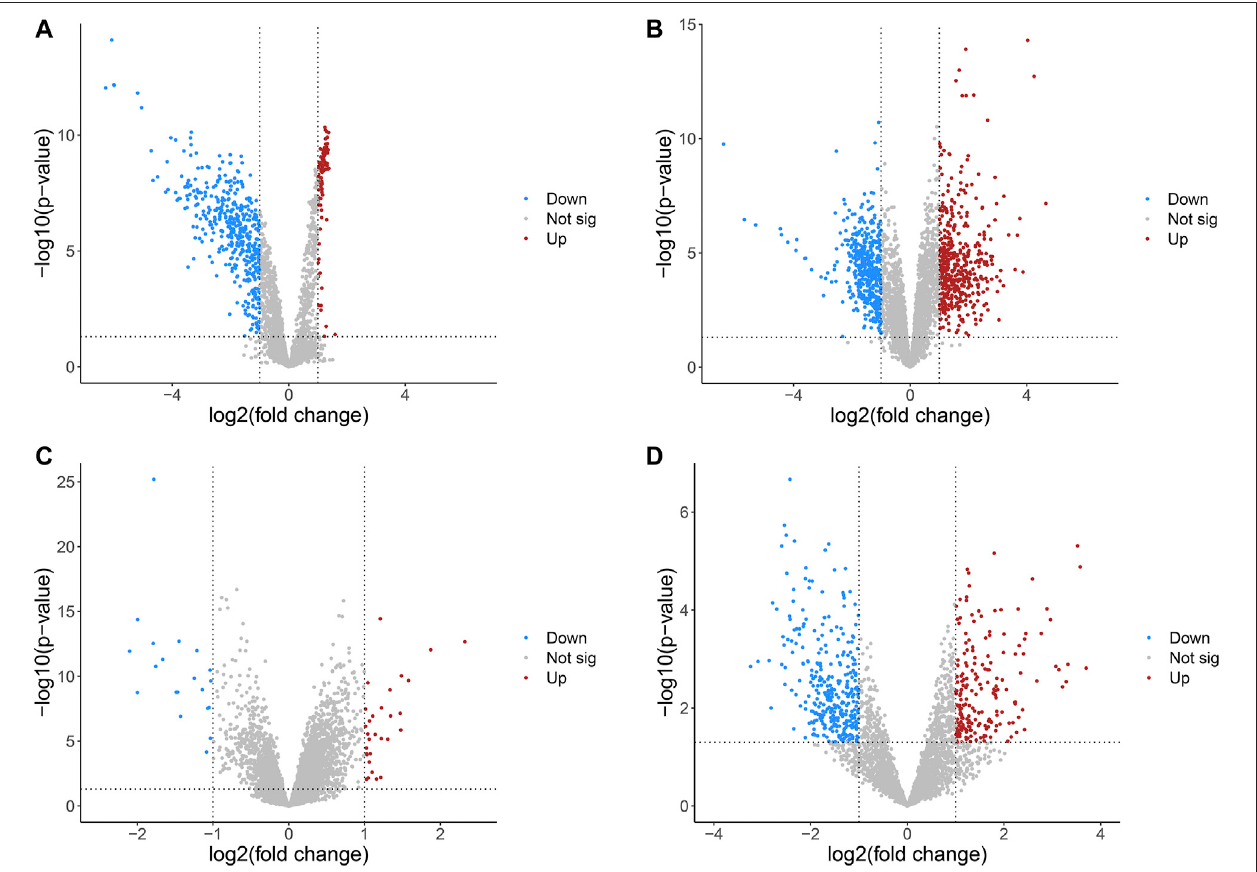
FIGURE2 | Volcano plots ofdifferentially expressed circRNAs inHCC from four GEO datasets. (A) GSE94508. (B) GSE97332. (C) GSE155949. (D) GSE164803. HCC, hepatocellular carcinoma; GEO, Gene Expression Omnibus.